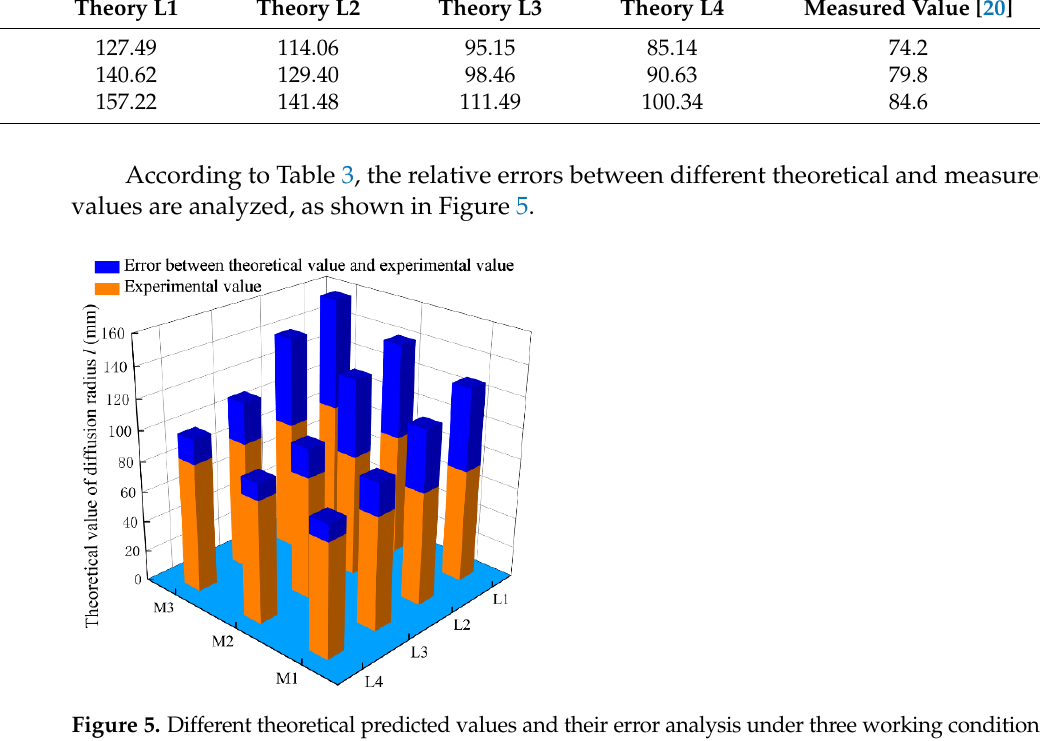
Table 3. Comparison between theoretical value and the measured value of the diffusion radius un ‐ der different parameters (unit: mm).